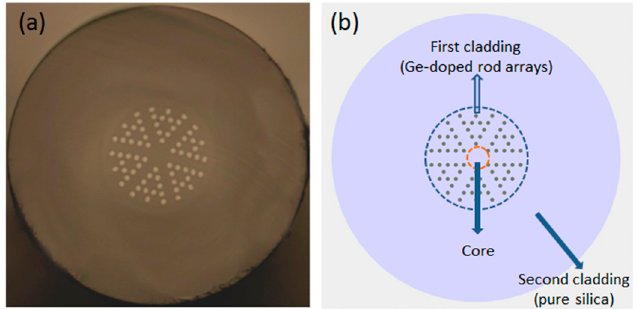
Figure 1. ( a ) Optical micrograph of the cross-section of an all-solid microstructure fiber (MOF); ( b ) Schematic representation of the cross-section.